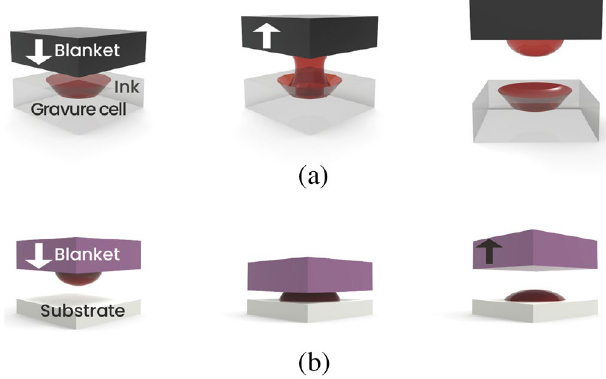
Figure 2. Ink transfer mechanism in gravure offset printing: ( a ) off step, ( b ) set